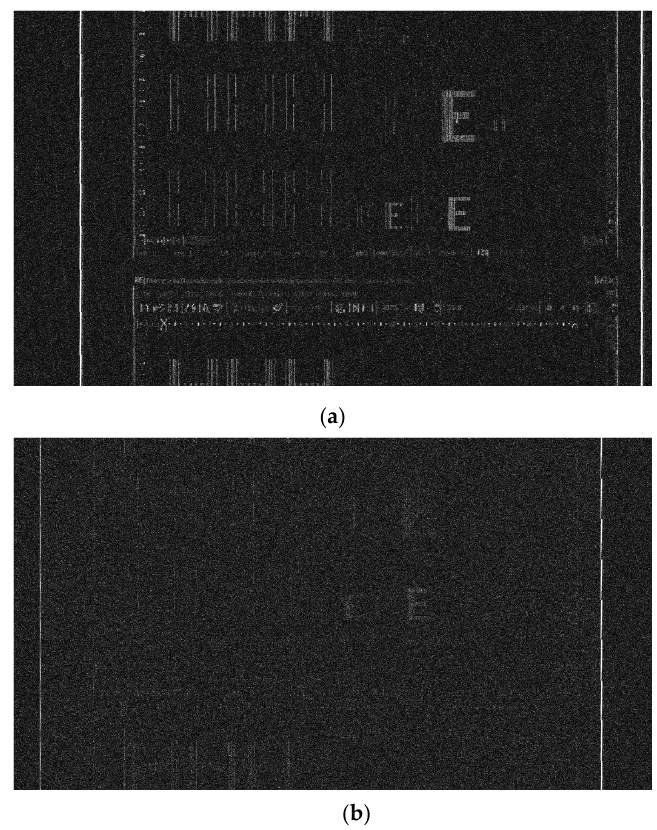
Figure 15. Reconstructed images for valuable emissions measured on frequency 753 MHz for two laptops type C : ( a ) laptop No. 10, ( b ) laptop No.